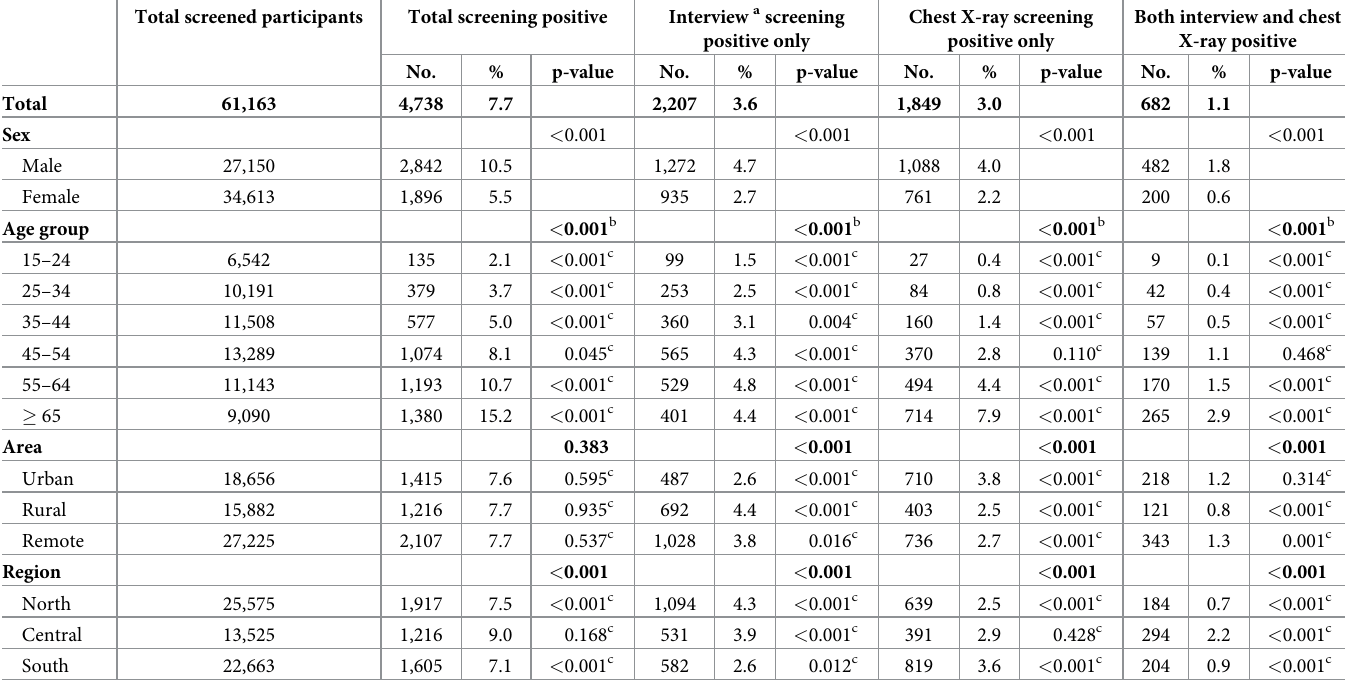
Table 2. Screening outcomes of the survey, by sex, age, area and region. Total screened